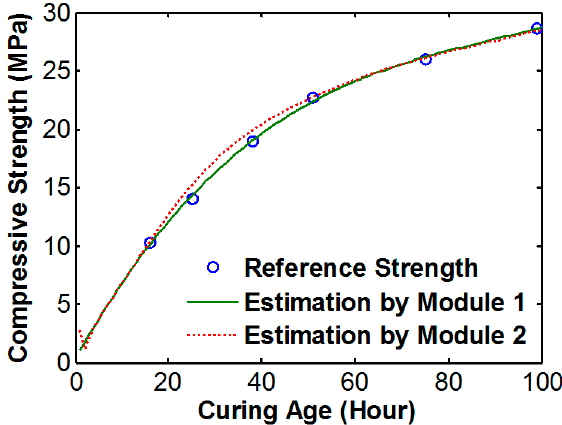
Figure 13. Strength estimation result using the artificial neural network (ANN).